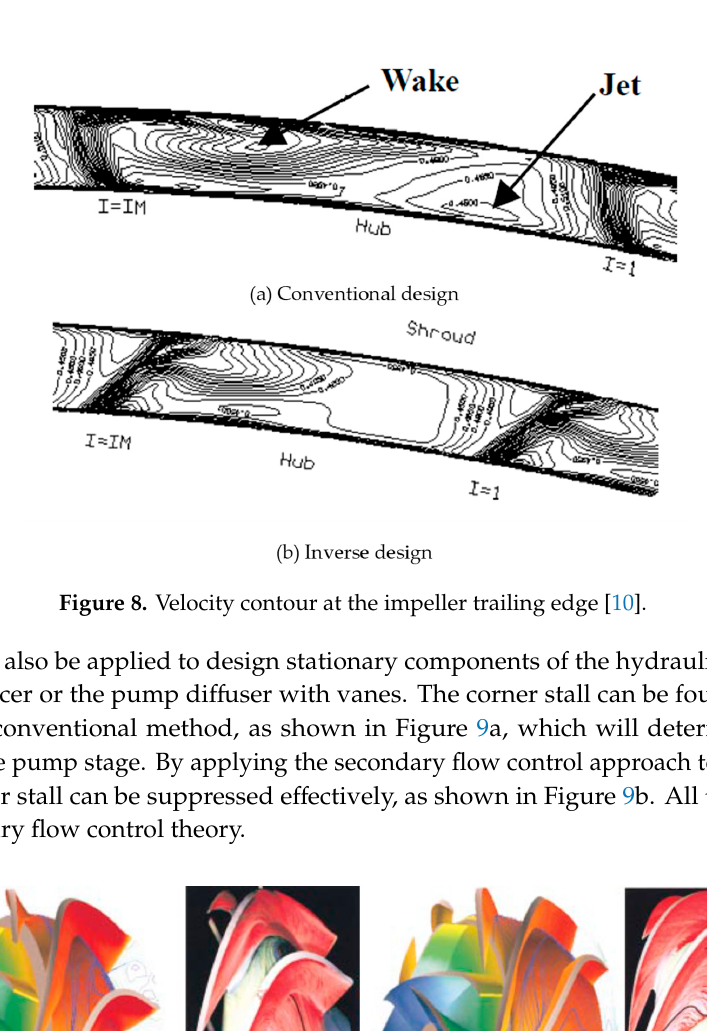
Figure 7. Velocity vectors on the blade suction surface [10].